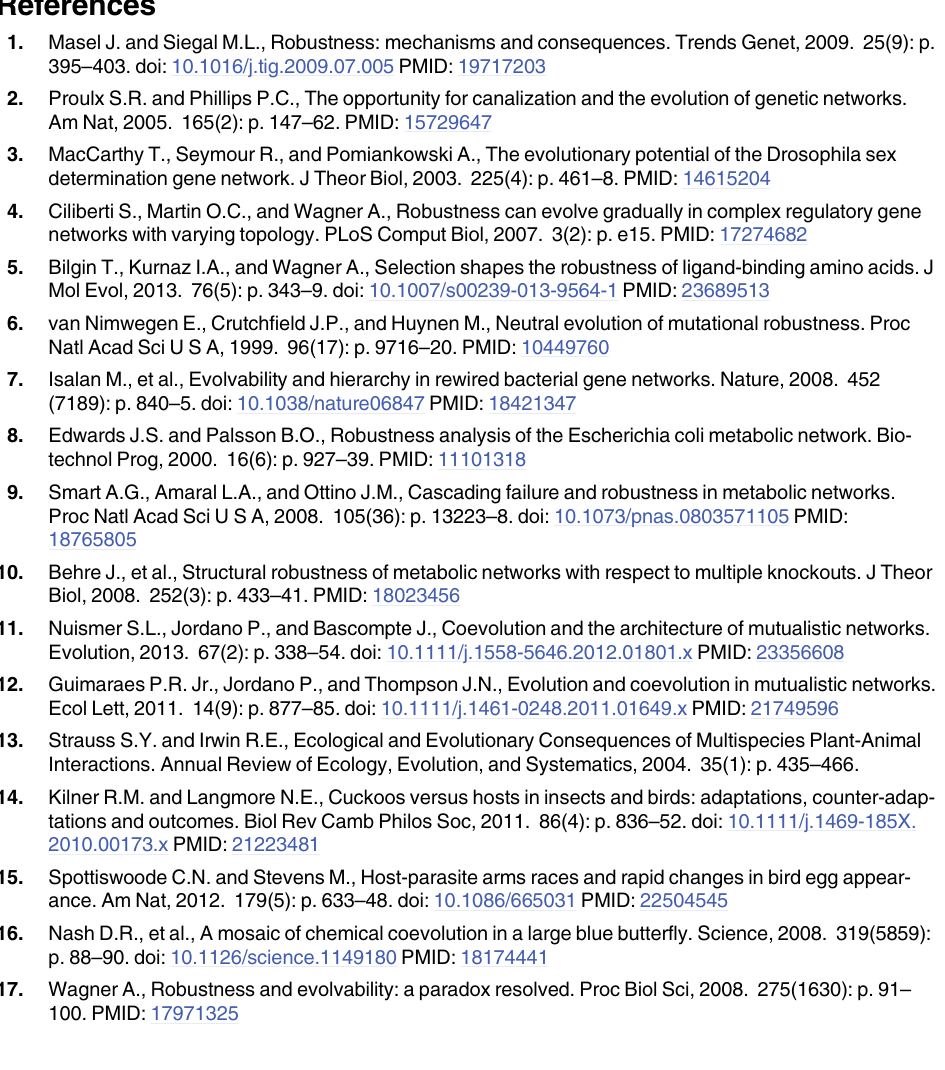
S14 Fig. Emergence of sensitivity (A, C) and the distribution of the frequency of interac- tions being sensitive among all N × N interactions (B, D) for different addition ( ρ ) and dele- tion ( ϕ ) rates. The format is equivalent to Figures Figs 2A and 4C respectively (where ρ = ϕ = 0.025). (A) and (B) are results for a 2.5X higher addition/deletion rate of ρ = ϕ = 0.0625, whereas (C) and (D) are for the 2.5X lower addition/deletion rate of ρ = ϕ = 0.01. Other param- eters remain as described in Methods (section “ Parameters ”